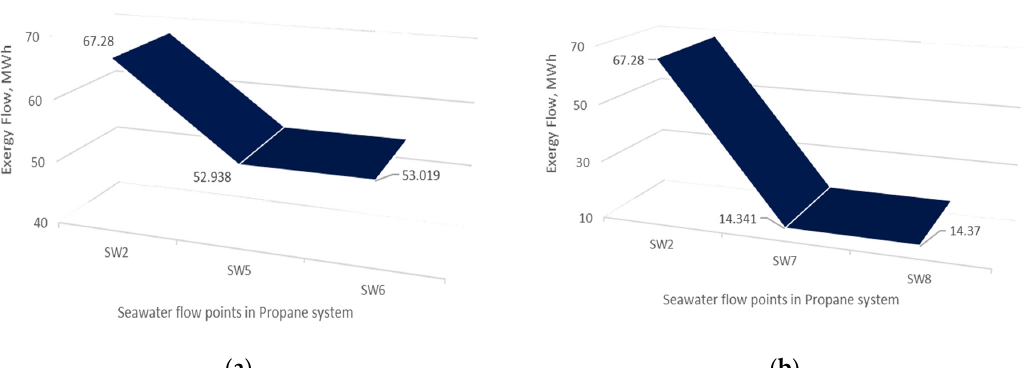
Figure 4. The Case 2 of seawater exergy flow in the regasification system. ( a ) The values of seawater exergy flow in regasification system: SW2, seawater inlet to the regasification system from heaters; SW5, seawater flow to propane evaporator; SW6, seawater output flow from propane evaporator. ( b ) The values of seawater exergy flow in the regasification system: SW2, seawater inlet to the regasification system from heaters; SW7, seawater flow to propane preheater; SW8, seawater flow output flow from propane preheater.